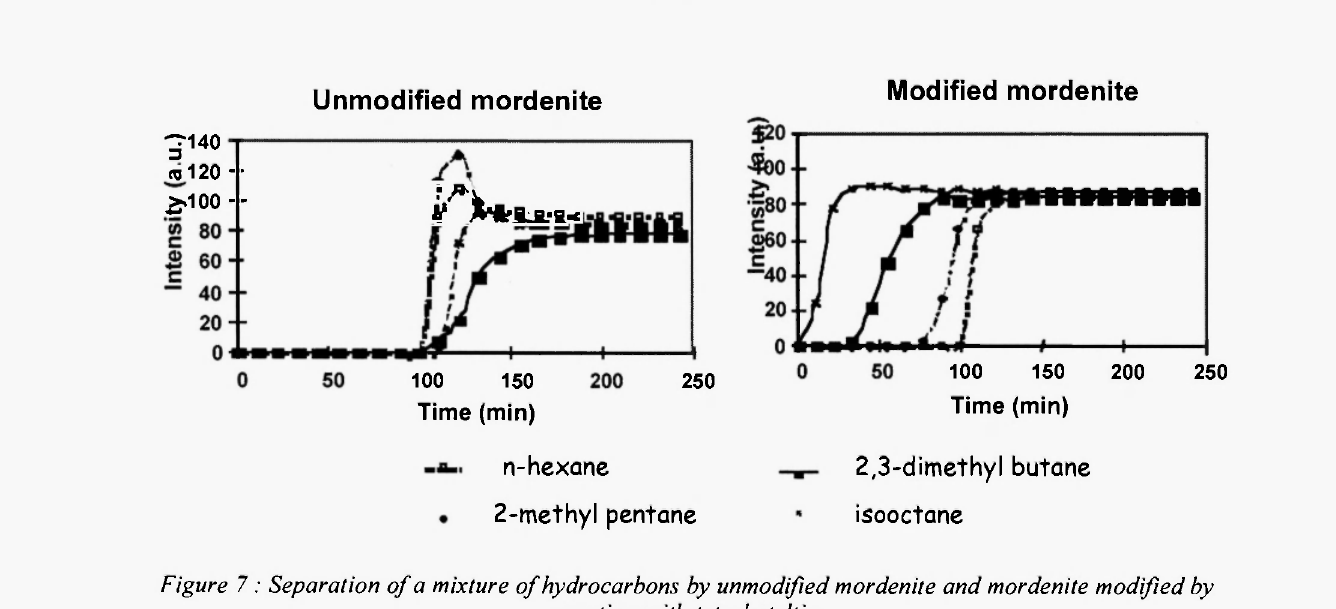
Figure 7 : Separation of a mixture of hydrocarbons by unmodified mordenite and mordenite modified by reaction with